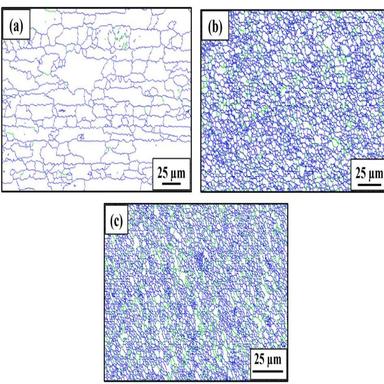
Grain boundary misoreintation map for (a) Base, (b) WOR_3 and (c) WR_3 condition. (In fig. blue color represents the HAGB's, and green color represents the LAGB's).